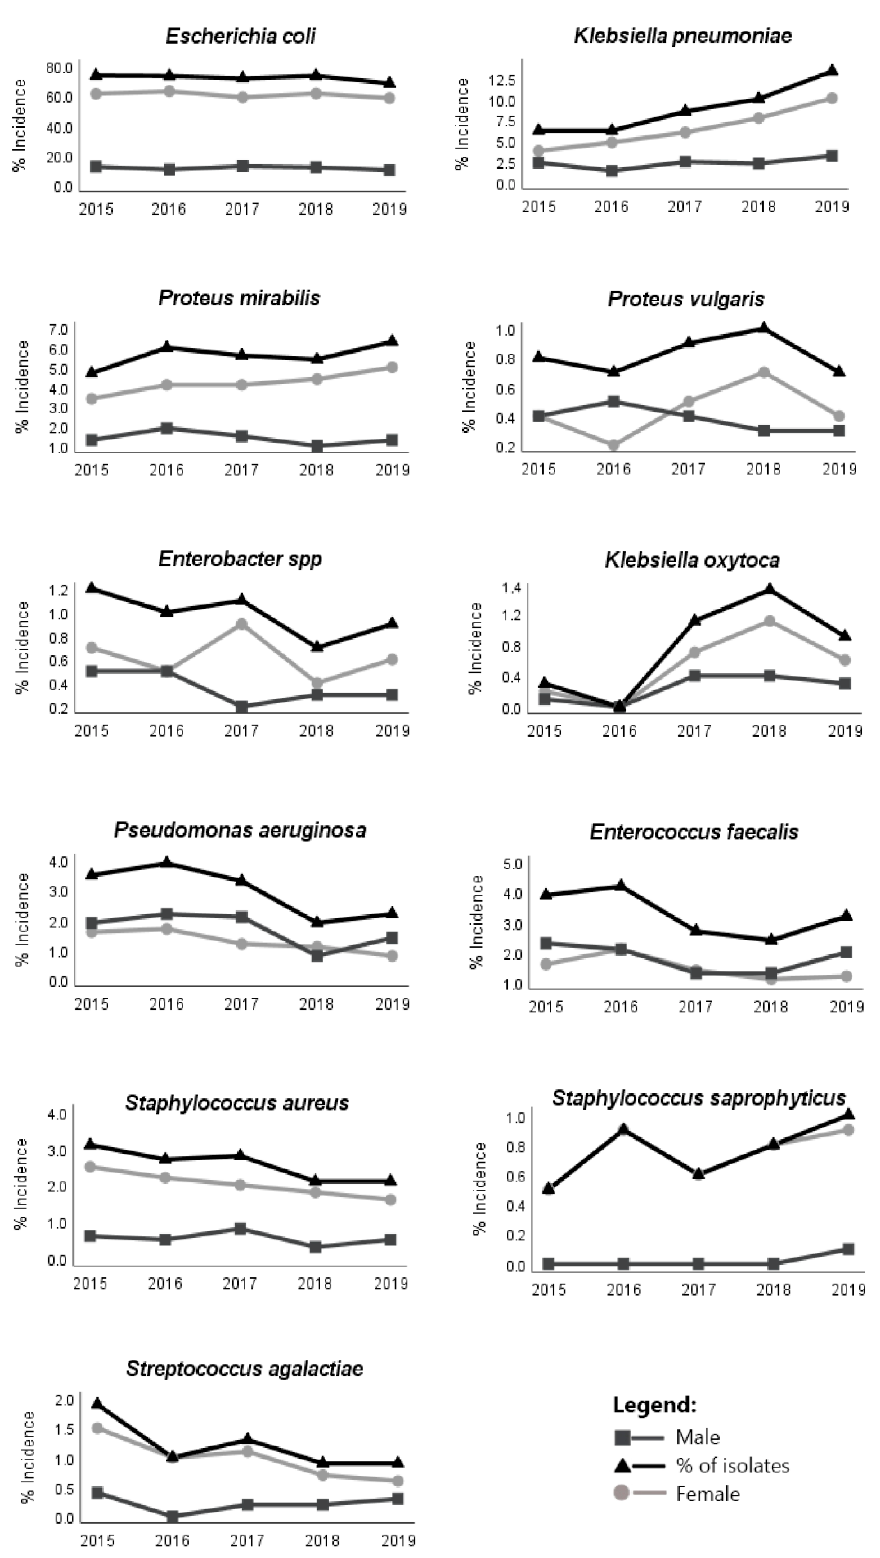
Figure 1. Incidence of the main bacteria implicated in UTIs by sex during the study period (2015– 2019).